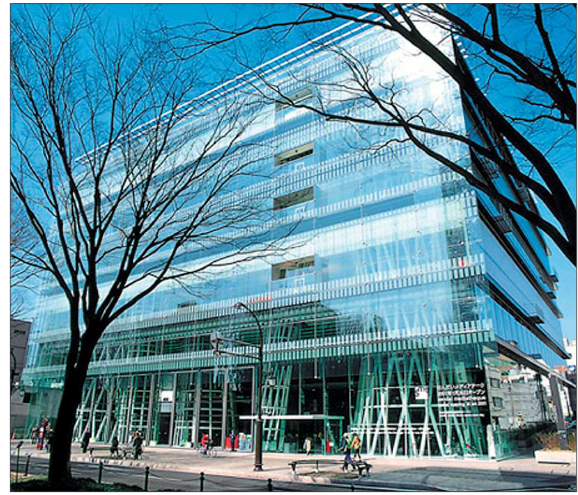
Fig 7. Sendai Town Library in Japan